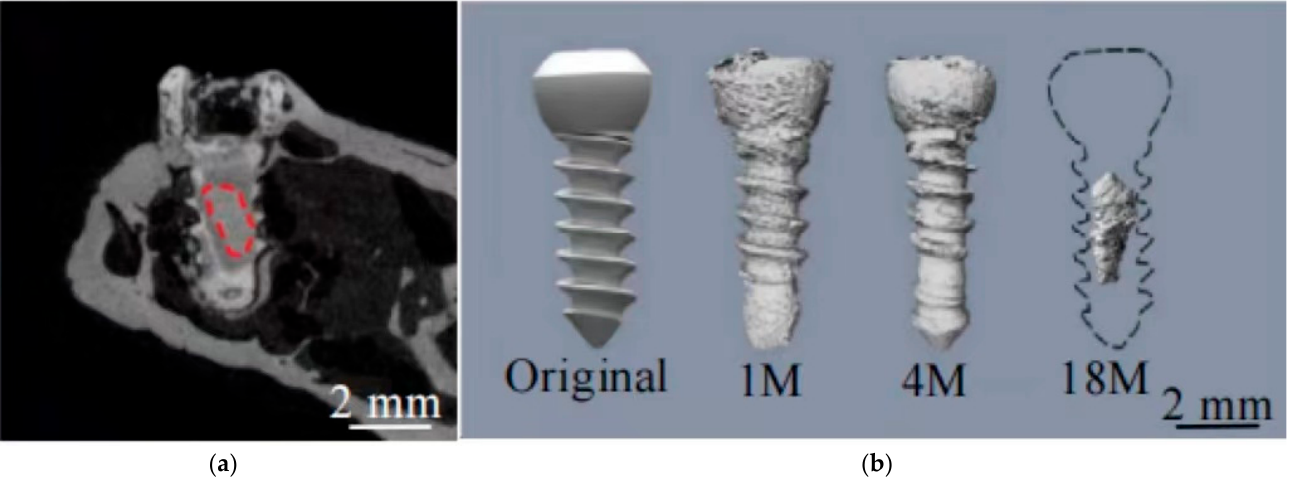
Figure 12. CT scans and 3D reconstruction of JDBM screw after 18 months implantation: ( a ) CT image of implanted screw (the original screw is marked by a red dashed line); ( b ) the original screw and segmented residual screw at 1, 4, and 18 months post-operation [200]. Reprinted from Corros. Sci., 113, Niu, J.; Xiong, M.; Guan, X.; Zhang, J.; Huang, H.; Pei, J.; Yuan, G., The in Vivo Degradation and Bone-Implant Interface of Mg-Nd-Zn-Zr Alloy Screws: 18 Months Post-Operation Results, 183– 187, 2016, with permission from Elsevier. Table 3. Results of in vivo tests on the biocompatibility of magnesium alloy